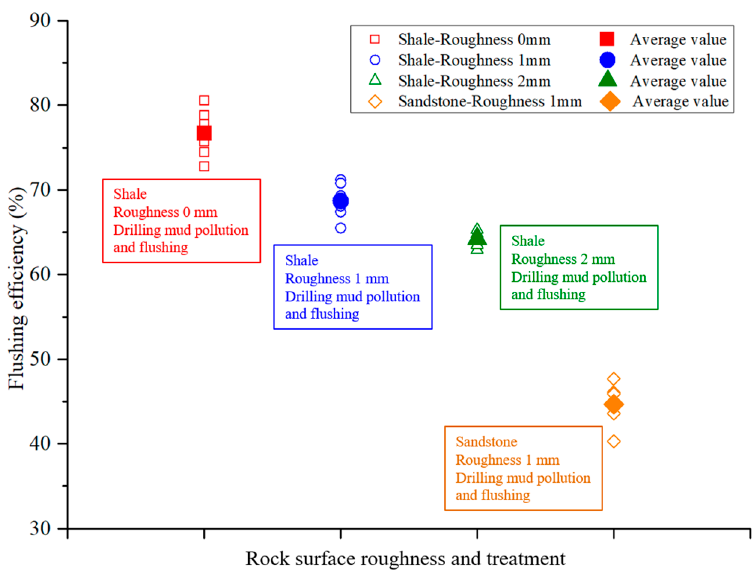
Figure 6. Flushing efficiency of rock surface with difference roughness and lithology.